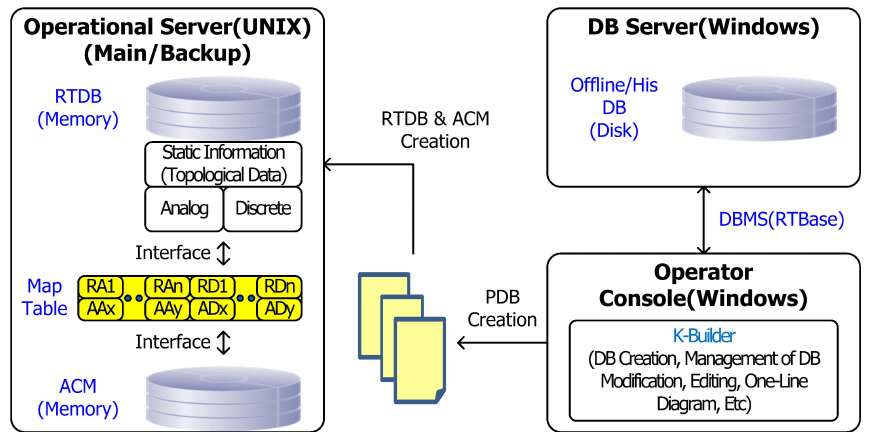
Figure 8. Database composition of the